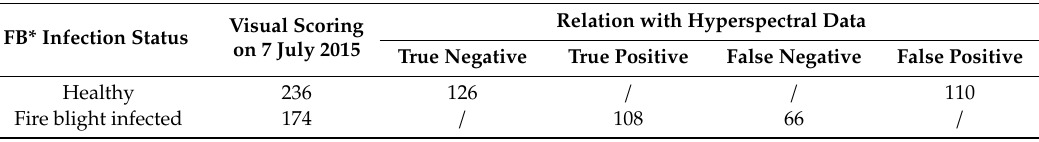
Table 2. Relation between visual field data of fire blight detection with the infection probability calculated based on the hyperspectral COSI-cam data of 7 July, 2015 and expressed as the number of trees classified as true positive, true negative, false positive and false negative.